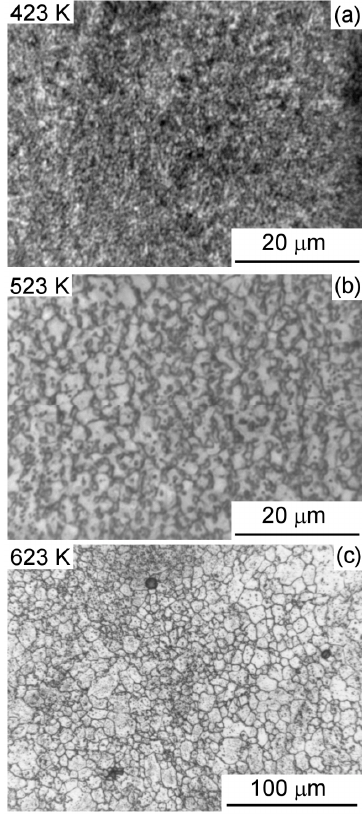
Figure 3. Grain structure at grip area in samples heated to ( a ) 423, ( b ) 523, and ( c ) 623 K.